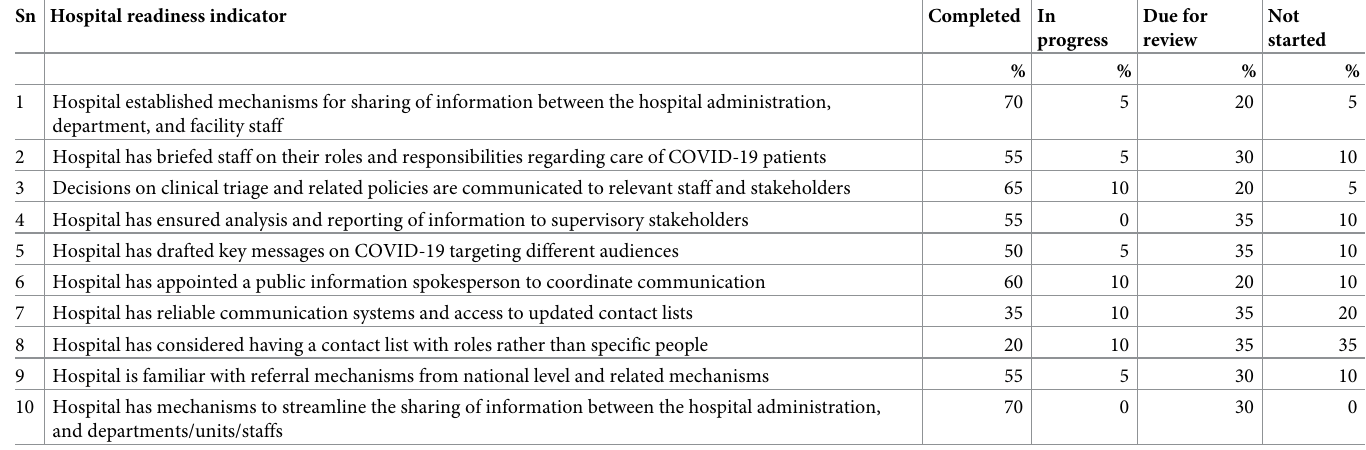
Table 8. Implementation of communication readiness indicators among 20 hospitals in Nigeria. Sn Hospital readiness indicator